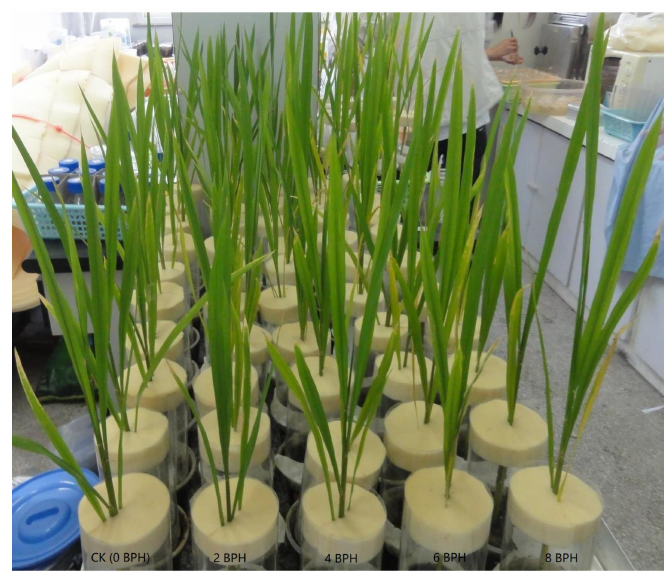
Figure 1. The rice plants damaged by 0~8 BPH 2rd-instar nymphs for 6